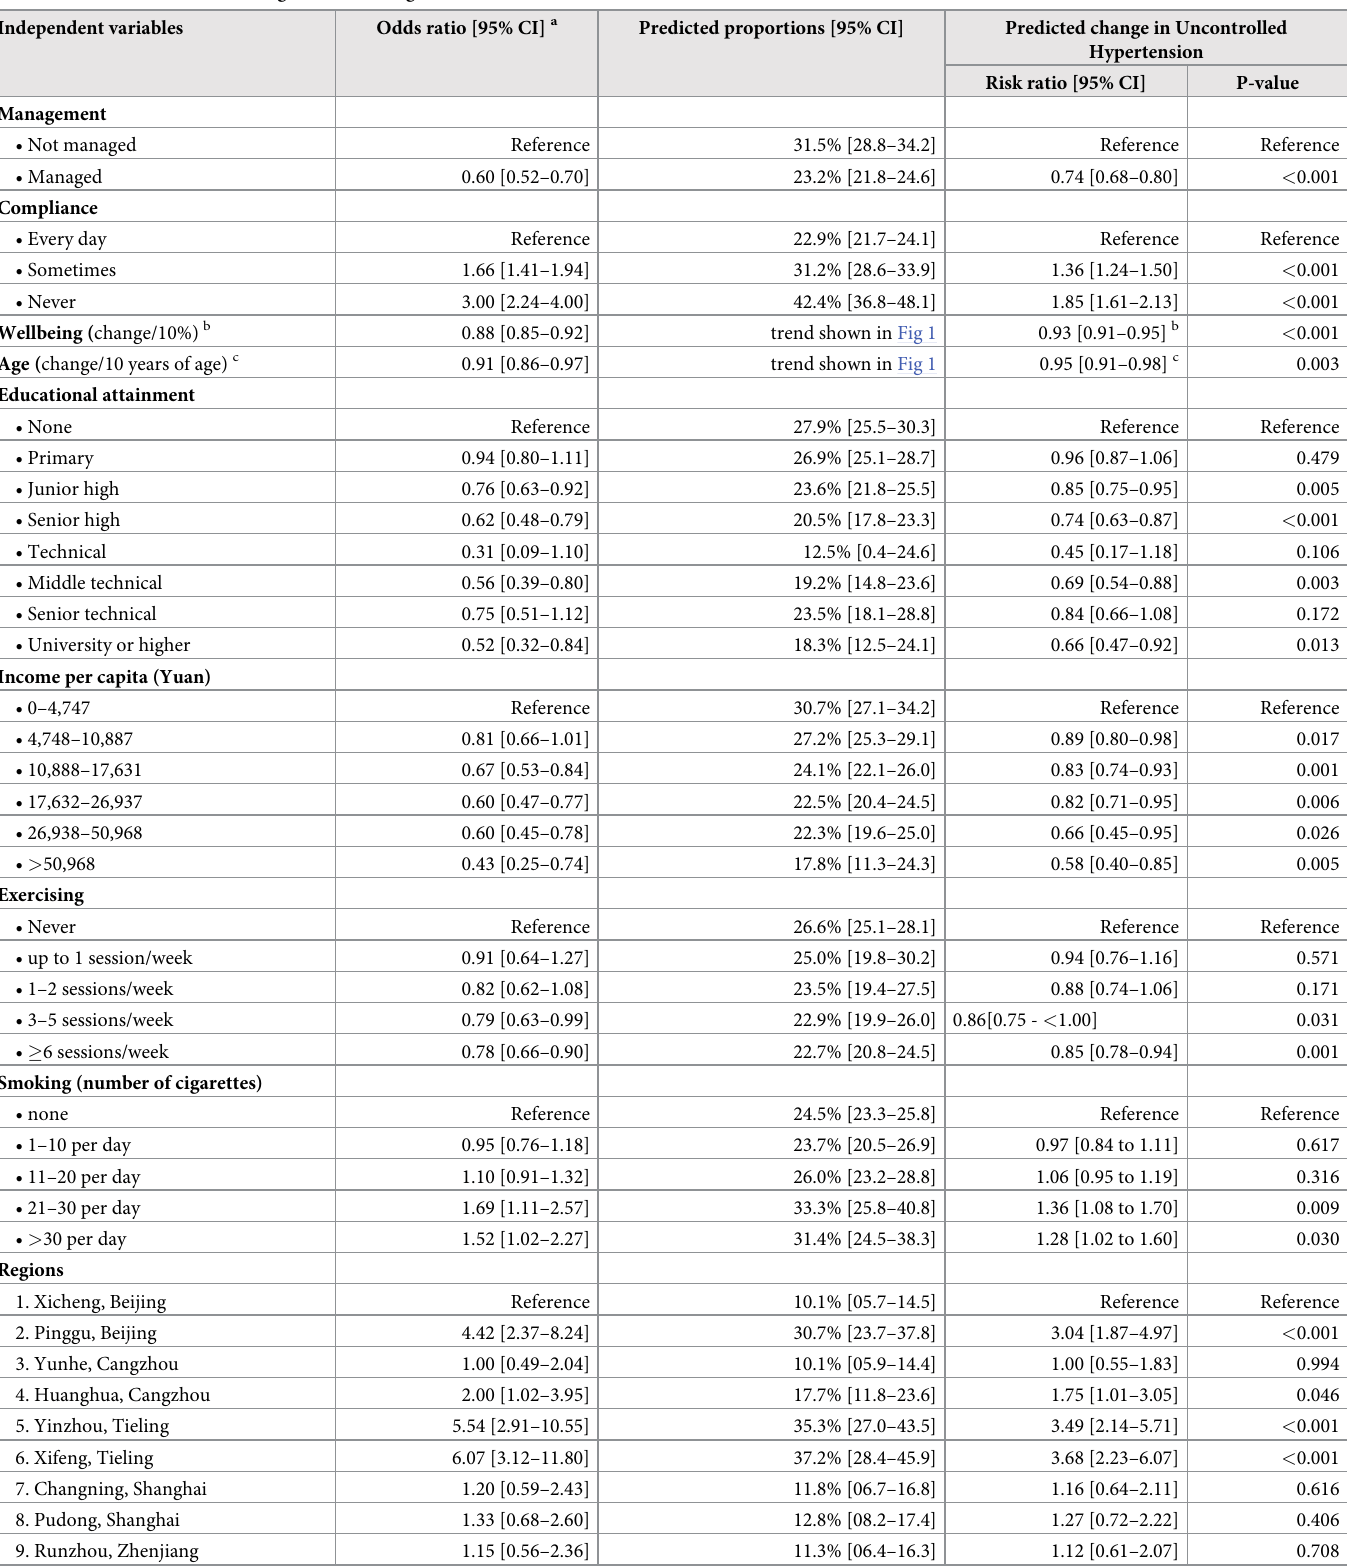
Table 5. Estimated effect of management from regression